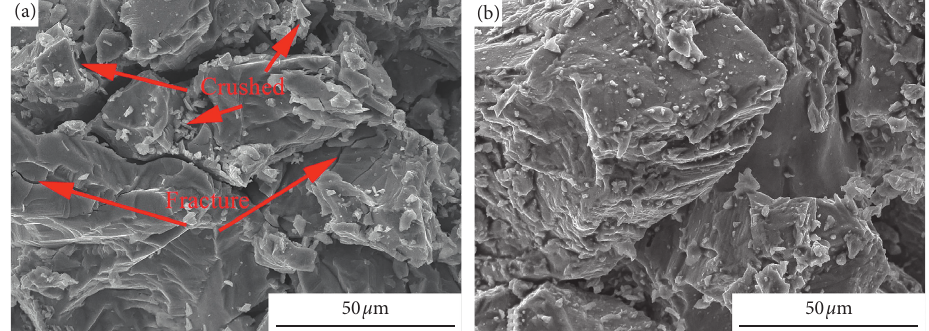
Figure 4: SEM images showing characteristic difference between green compact structure for (a) TiH pressure